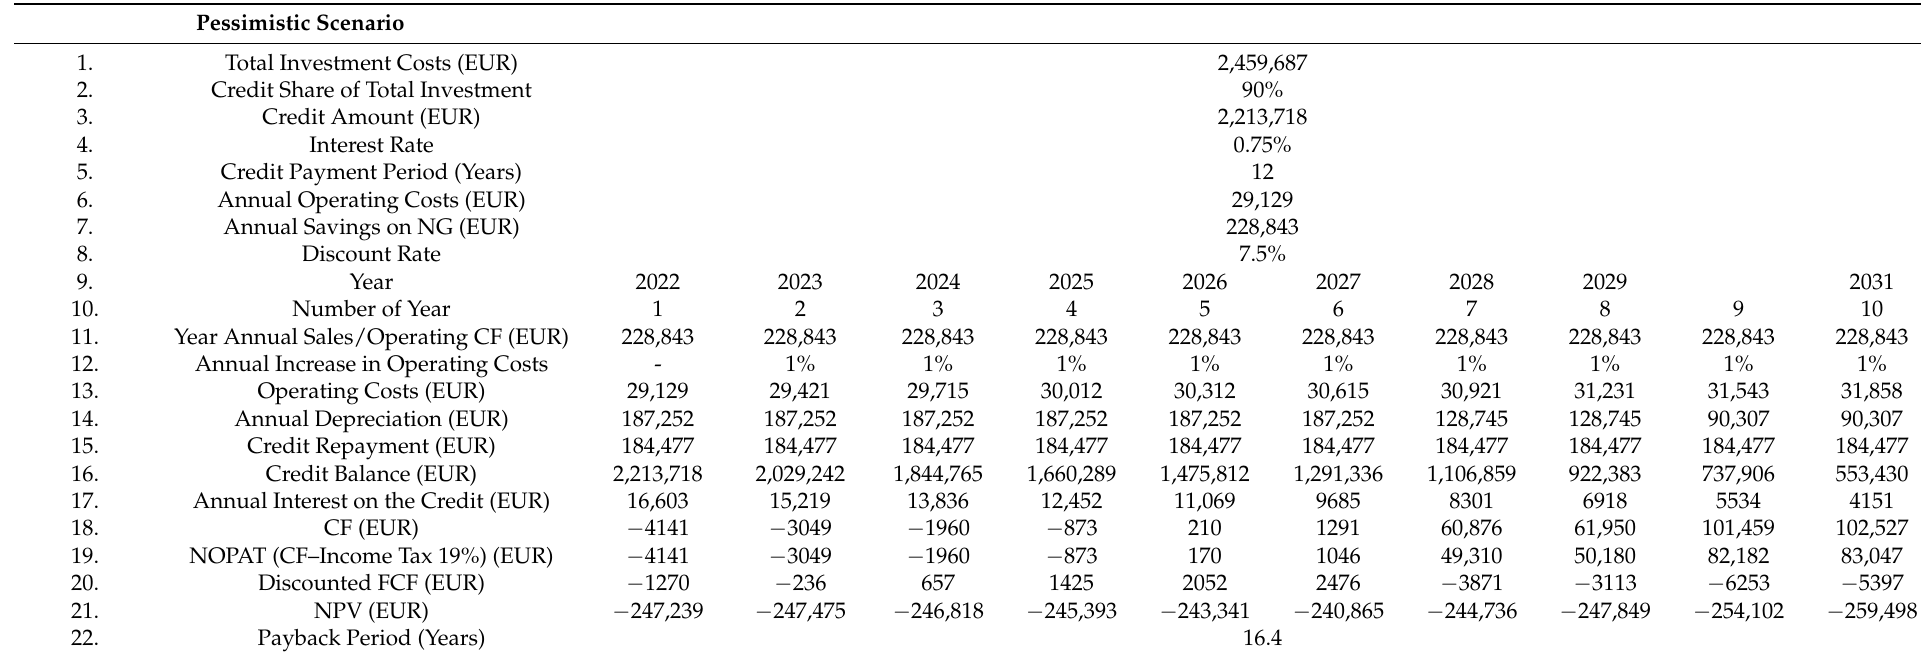
Table 6. Calculation of the evaluation of the economic efficiency of the implemented geothermal project for the pessimistic